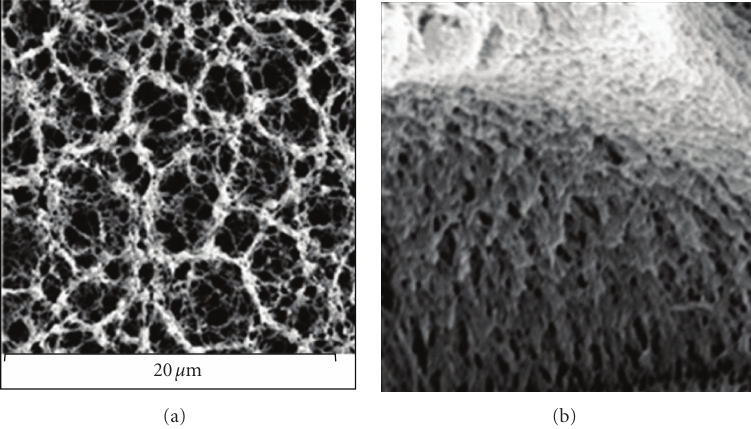
Figure 9: Scanning Electronic Microscopy of a Liquid crystal based device.